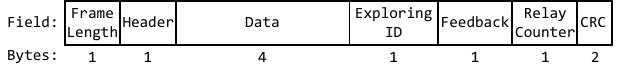
Figure 2. An example of an application-level frame structure in LiM. By design, the length of the data field (payload) is set to eight bytes in LiM. The exploring ID field is to notify the nodes is to carry a response for the learning